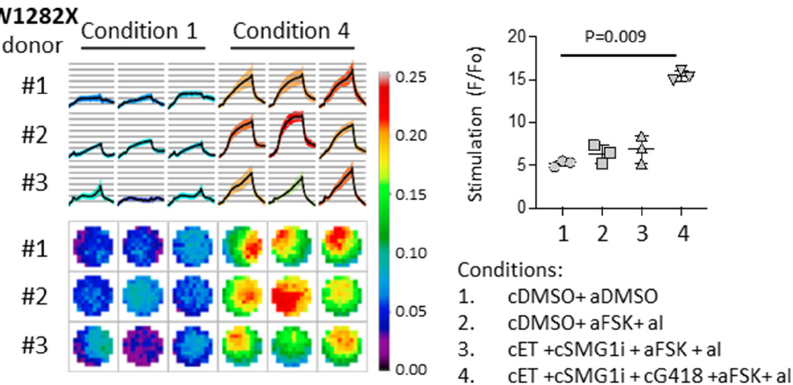
Figure 4. FMP plate reader studies of investigational compound responses on nasal cultures from 3 donors, each homozygous for W1282X. The traces on the ( left ( top )) show reproducible responses to forskolin plus ivacaftor (I) after pre-treatment with ET+SMG1i and G418. The coloured regions in the traces are +/ − 1 SD of the mean at each time point. The mean is indicated as the black tracing. The traces are colour-coded according to the magnitude of the response. The dots in the ( lower-left ) panel represent a different visualization, with each dot showing the peak FMP response in each culture, coloured according to magnitude. On the ( right ), the mean FMP responses for the three donors are shown. There was a significant augmentation of the functional expression following treatment with condition 4, as determined using Student’s paired “ t ”